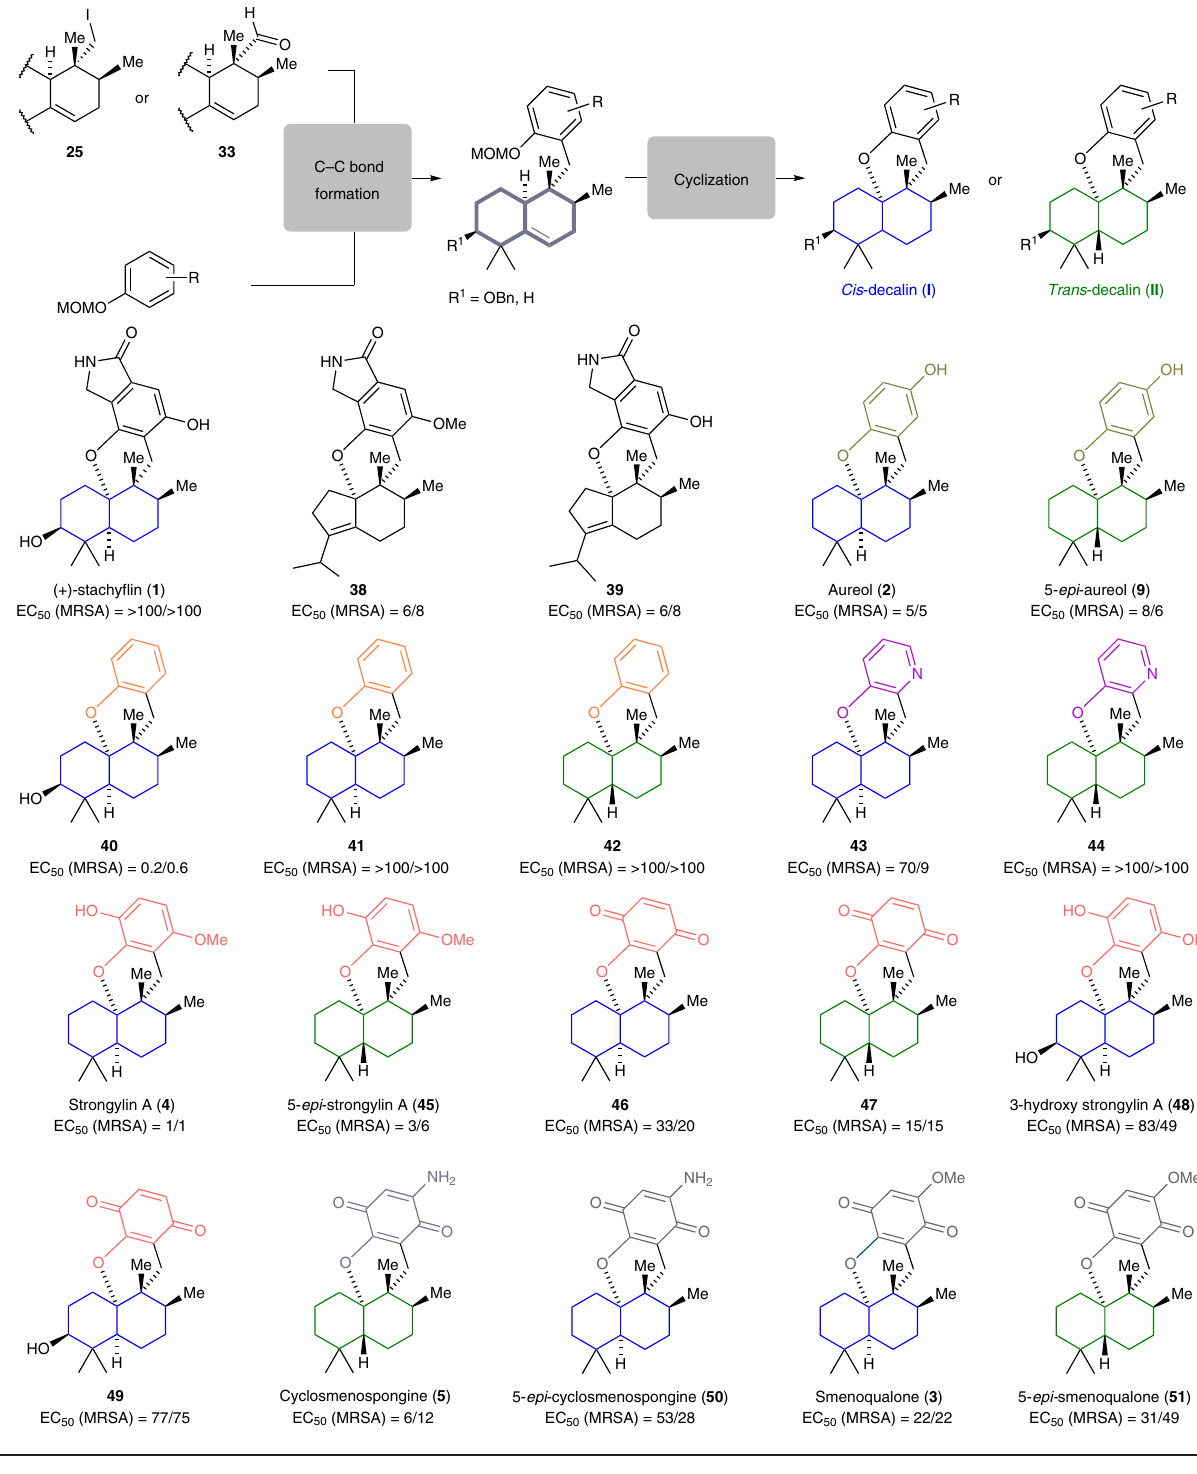
Fig. 6 Extension of the modular synthetic platform. Structural variation of the arene and decalin component enabled rapid extension of the natural products library and provided access to several non-natural analogs that were previously inaccessible via semi-synthesis. Each of the shown molecules depicted was prepared in seven or fewer steps starting from iodide 25 or aldehyde 33 . Color coding was used to indicate the decalin stereochemistry (coding: blue, cis -decalin; green, trans -decalin) and to highlight the modi fi ed arene component. The effective concentrations (EC two MRSA strains (DSM 11822/RKI 11-02670) are given in μ M